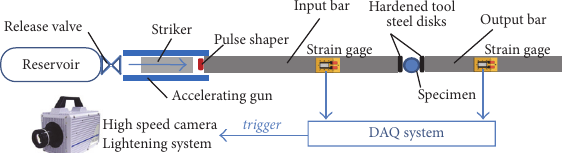
Figure 3: Scheme of the Split Hopkinson Pressure Bar for high loading rate